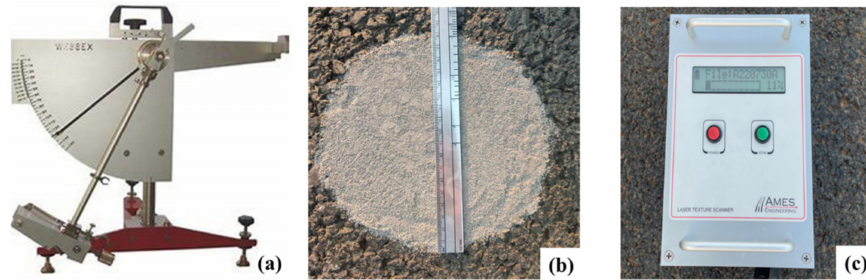
Figure 2. Portable pendulum tester ( a ), sand patch test ( b ), Laser Texture Scanner ( c ).